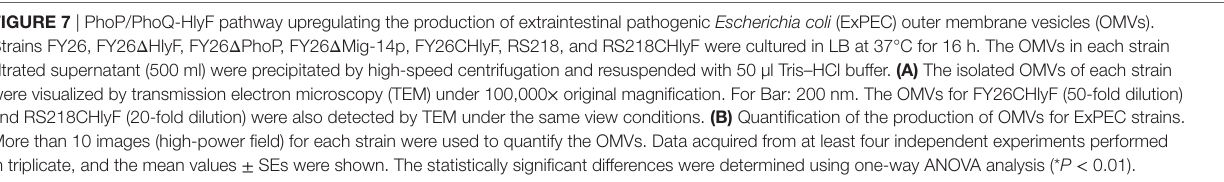
FigUre 7 | PhoP/PhoQ-HlyF pathway upregulating the production of extraintestinal pathogenic Escherichia coli (ExPEC) outer membrane vesicles (OMVs). Strains FY26, FY26 Δ HlyF, FY26 Δ PhoP, FY26 Δ Mig-14p, FY26CHlyF, RS218, and RS218CHlyF were cultured in LB at 37°C for 16 h. The OMVs in each strain filtrated supernatant (500 ml) were precipitated by high-speed centrifugation and resuspended with 50 µl Tris–HCl buffer. (a) The isolated OMVs of each strain were visualized by transmission electron microscopy (TEM) under 100,000 × original magnification. For Bar: 200 nm. The OMVs for FY26CHlyF (50-fold dilution) and RS218CHlyF (20-fold dilution) were also detected by TEM under the same view conditions. (B) Quantification of the production of OMVs for ExPEC strains. More than 10 images (high-power field) for each strain were used to quantify the OMVs. Data acquired from at least four independent experiments performed in triplicate, and the mean values ± SEs were shown. The statistically significant differences were determined using one-way ANOVA analysis (* P <